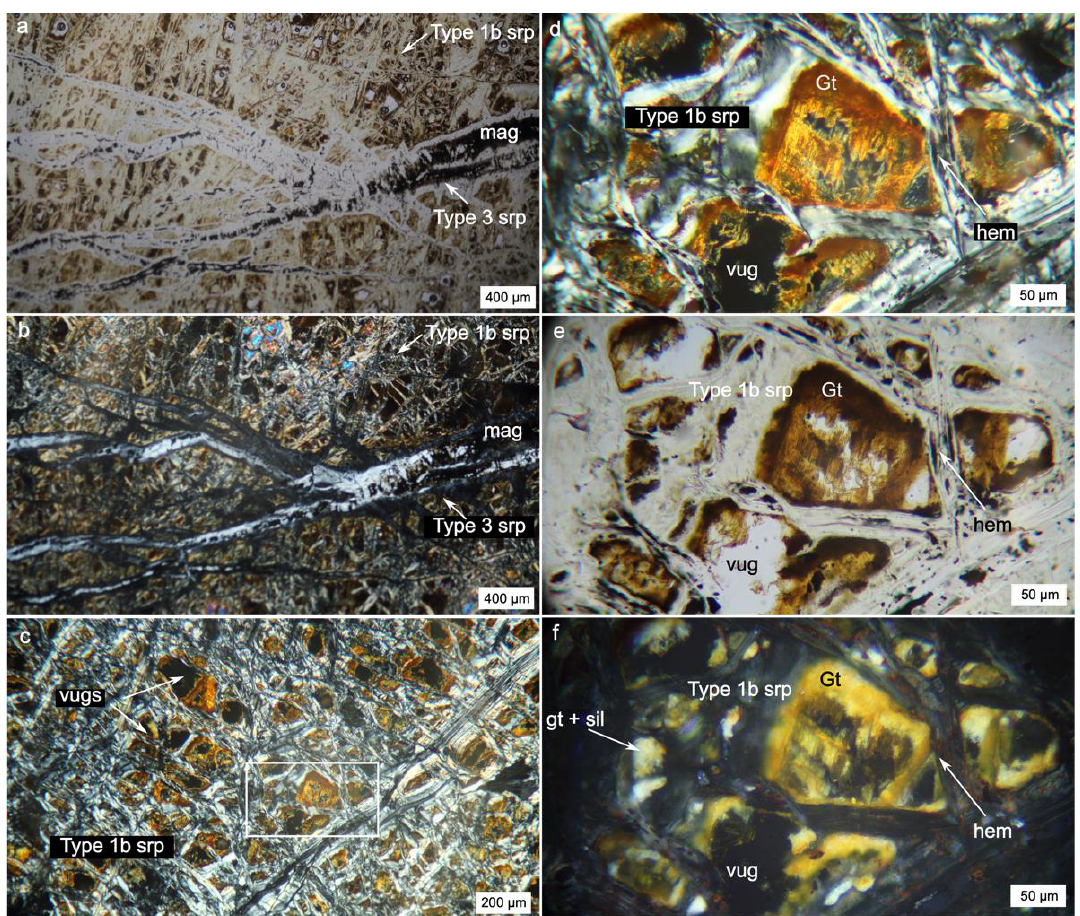
Figure 4. Upper saprolite sample N-650R in thin section. ( a ) Sample N-650R is a heavily serpentinized rock with almost no primary olivine remaining. Type 1b (mesh-type) serpentine (srp) surrounding partially or completely dissolved olivine, crosscut by type 3 (vein-type, magnetite-rich) serpentine in plane-polarized transmitted light. ( b ) Same as ( a ) in crossed-polarized transmitted light. ( c ) Occurrence of poorly crystalline Fe-oxides (gt), as well as minor amorphous silica (sil), as precipitates within dissolution vugs after olivine, in crossed-polarized transmitted light. ( d ) Detail of white box in ( c ), showing a dissolution vug filled with Fe-oxides. Surrounding mesh serpentine (type 1b) contains minor hematite (hem), likely from oxidation of magnetite. ( e ) Same as ( c ) in plane-polarized transmitted light. ( f ) Same as ( c ) in crossed-polarized reflected light, showing bright orange internal reflections of poorly crystalline Fe-oxides, red internal reflections of hematite, and white internal reflections of amorphous